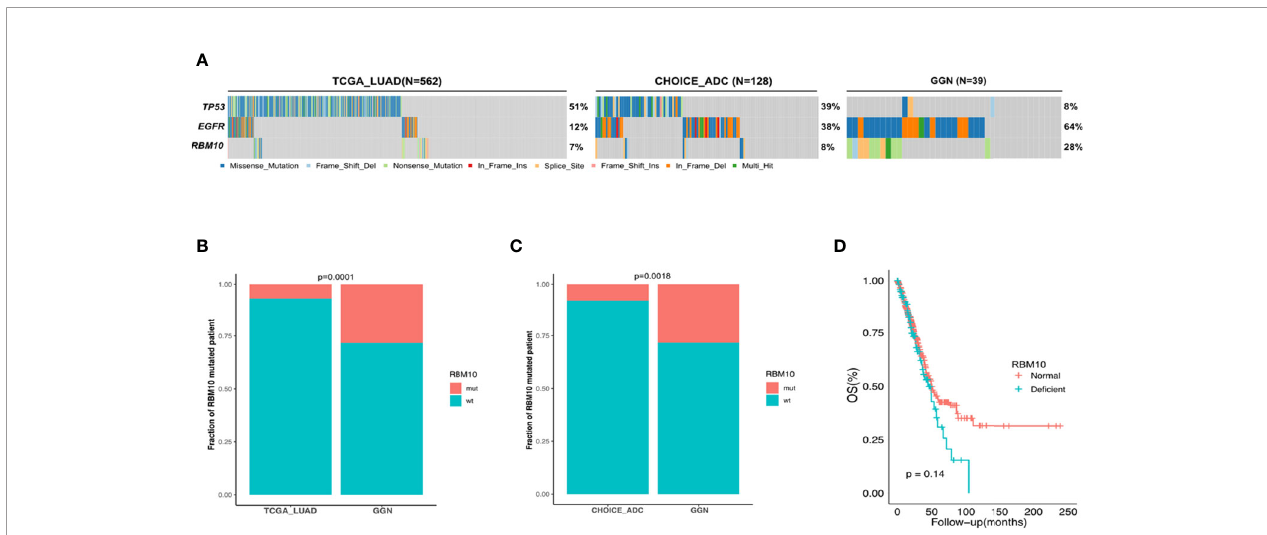
FIGURE 1 | RBM10 is highly mutated in early-stage LUAD. (A) The mutational frequency of RBM10 in the TCGA_LUAD, CHOICE_ADC and GGN cohorts. (B, C) RBM10 mutation rate is signi fi cantly higher in GGN cohort than those in the TCGA_LUAD (B) and CHOICE_ADC (C) cohorts. (D) RBM10 de fi ciency leads to shorter overall survival in